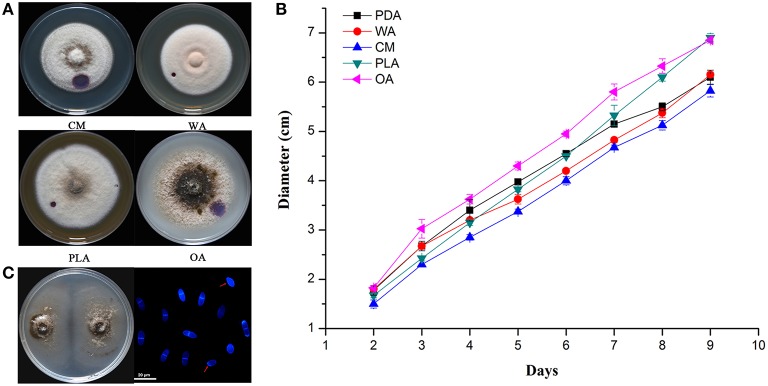
Morphological and physiological characteristics of isolate ZJ-1. (A) The colonies morphology of ZJ-1 on different media after 9-day incubation. (B) The growth rate of ZJ-1 on CM, WA, PLA and OA plates. The diameter of each colony was measured every 24 h. (C) Conidia formation on 1/3 PDA plates after 2 weeks incubation. The conidia were stained with calcofluor white and visualized by Leica TCS SP5 imaging system (Wetzlar, Hesse-Darmstadt, Germany). Bar was 20 μm.